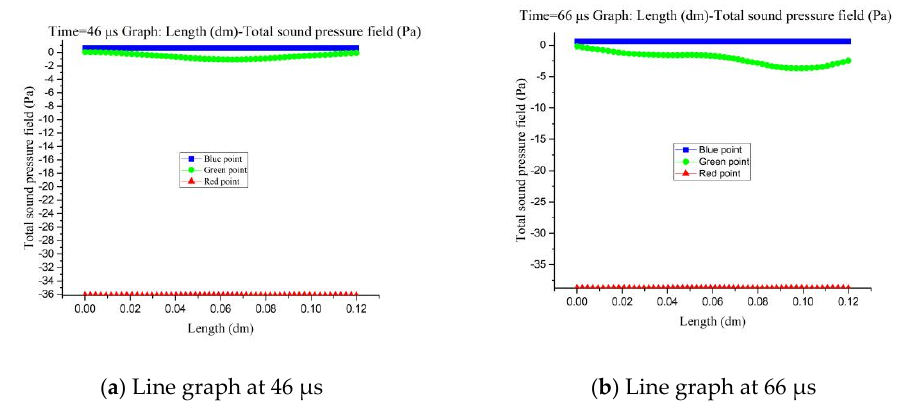
Figure 10. Sound pressure change at the acquisition point (sound pressure rise at the switch point): ( a ) Line graph at 46 µs; ( b ) line graph at 66 µs.